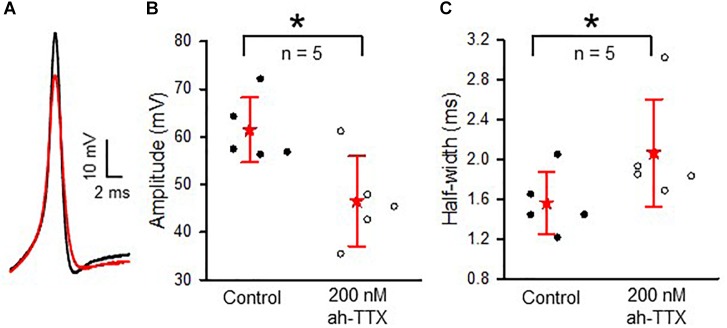
Contribution of Nav1.6-mediated current to action potential shaping in PZ calyces. (A) Averaged action potentials (n = 12 for each trace) in a PZ calyx (P21) in current clamp. Membrane was hyperpolarized briefly (–50 pA, 35 ms) to elicit action potentials in control conditions (black trace) and in the presence of 200 nM 4,9-ah-TTX (red trace). (B) In a total of five cells (ages P20-P25), application of 200 nM 4,9-ah-TTX decreased the mean action potential amplitude from 61.4 (6.8) mV to 46.5 (9.4) mV (P = 0.017) and (C) broadened action potential half-width from 1.56 (0.3) ms to 2.06 (0.5) ms (P = 0.014). ∗P < 0.05. For each calyx in (B,C), an average of 6–30 action potentials was obtained. External solution was L-15, electrode solution was K+ based.